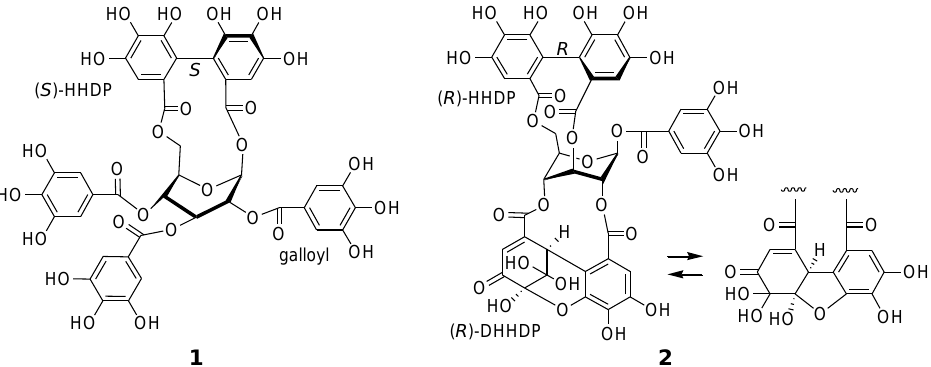
Figure 2. Structures of davidiin ( 1 ) from Persicaria capitata and geraniin ( 2 ) from Persicaria chinensis.